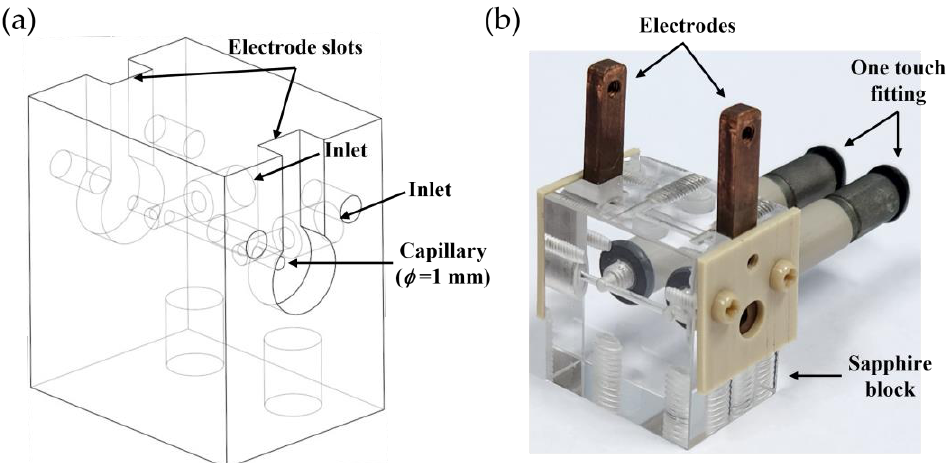
Figure 1. ( a ) Designed and ( b ) manufactured one-body capillary gas cell made of a sapphire. For the gas delivery, two one-touch fittings are directly connected to the sapphire block. Electrodes are